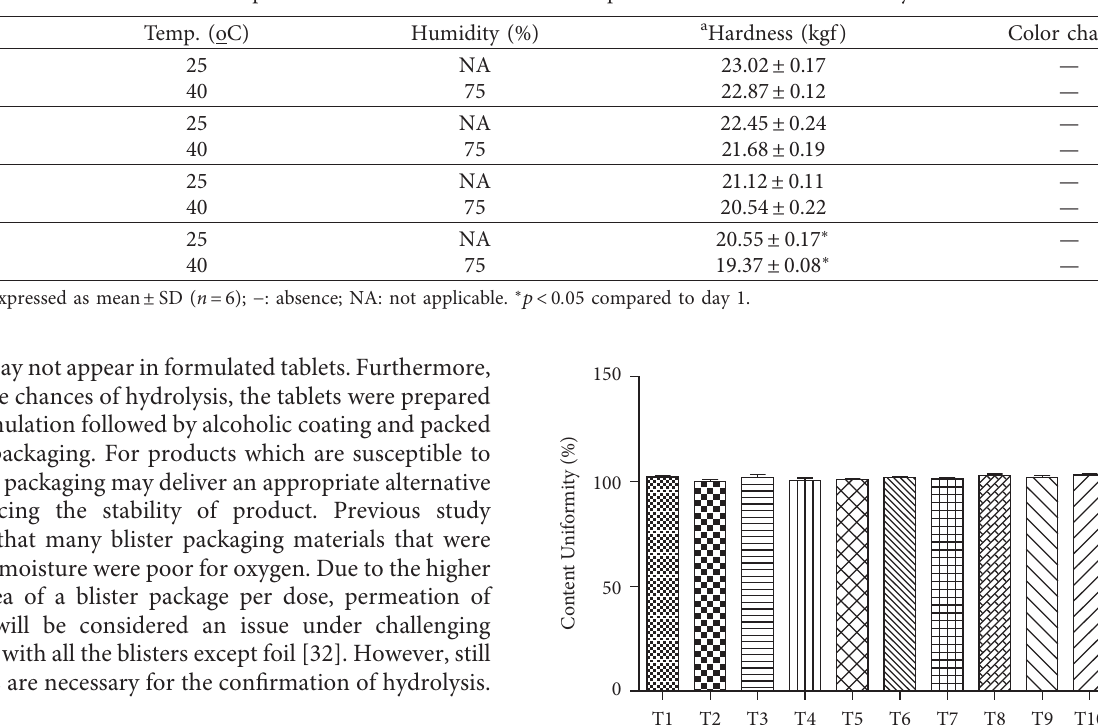
Table 10: Comparative evaluation between room temperature and accelerated stability.